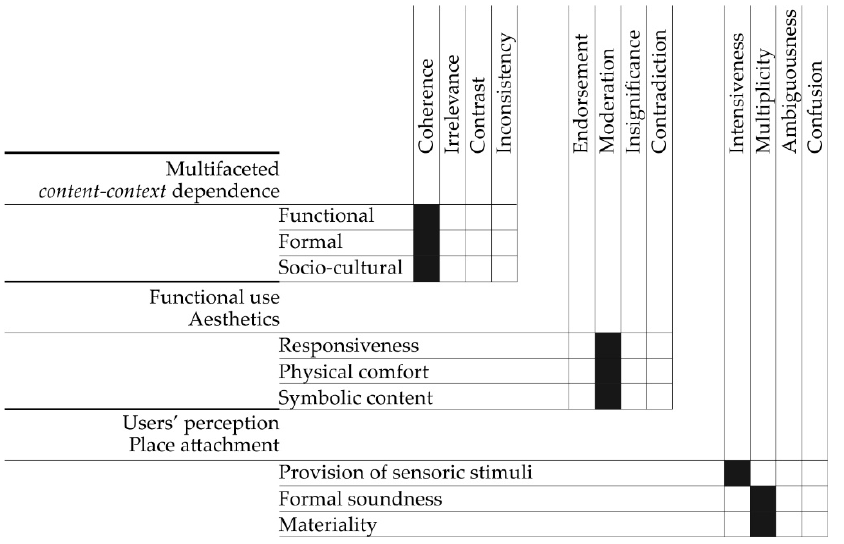
Figure 2. The qualitative evaluation of the area relation determined in function of the application of building techniques within the main criteria group. Case study: CKK Jordanki Congress and Culture Centre, Toru ń .